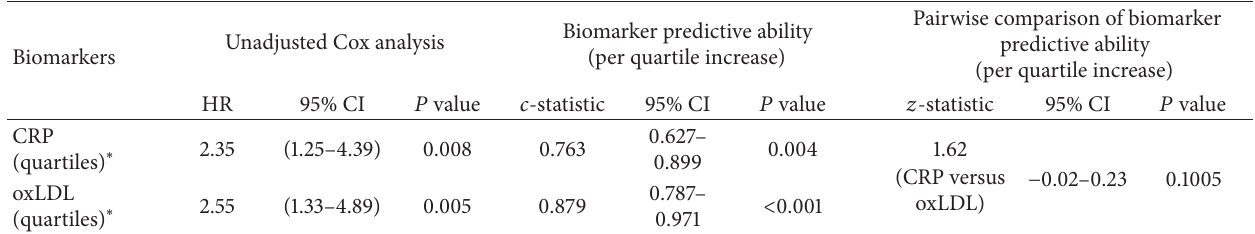
Table 4: Univariate Cox proportional hazard analysis for the association of biomarkers with the occurrence of hypertension in lone AF